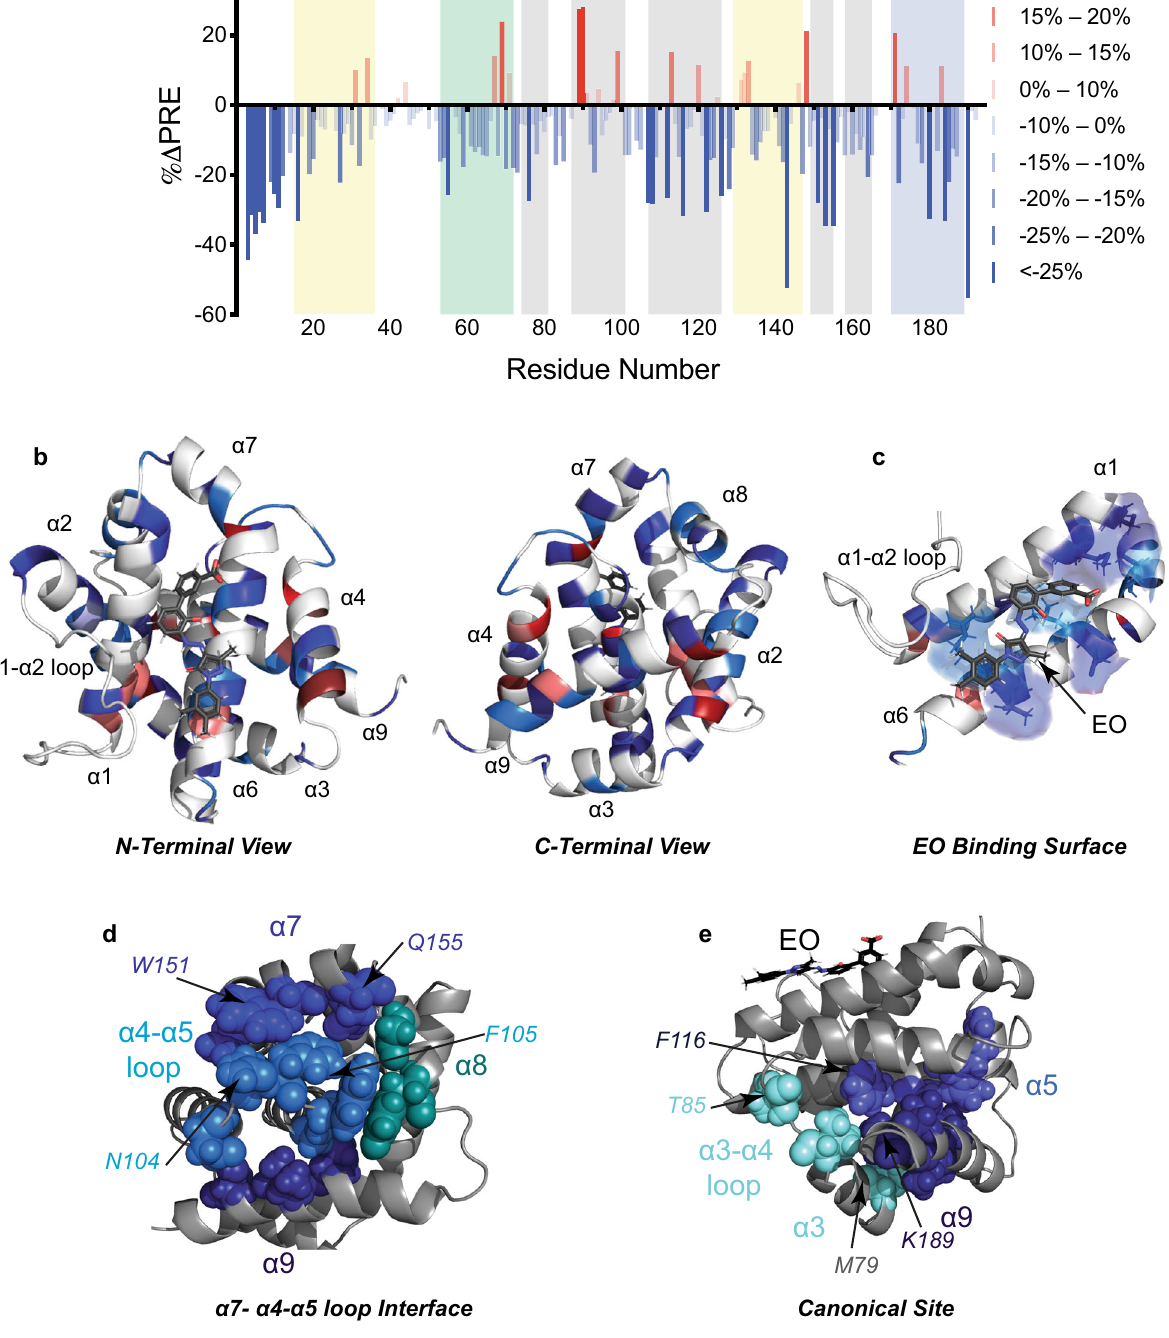
Fig. 5 NMR-based evidence of Eltrombopag-mediated BAX inhibition. a EO-induced differences in peak intensity ratio (PRE) of peaks in the presence and absence of the soluble paramagnetic probe hydroxyl-TEMPO. Percentage change in PRE is plotted with respect to BAX residue number. Residues that exhibit increased or decreased PRE are labeled in shades of red and blue, respectively, the color gradient corresponding to the fi gure key. Residues associated with the N-terminal trigger site, BH3 domain, canonical site, and transmembrane domain are highlighted in yellow, green, gray, and blue, respectively. b Ribbon representation of BAX-EO complex with mapping of residues undergoing signi fi cant differences in PRE as shown in ( a ). c Ribbon representation of EO-binding site with residues undergoing signi fi cant change in PRE colored corresponding to ( a ) and represented as a transparent surface with stick representation of residues. d , e Cluster of residues about the α 7/ α 4 – α 5 loop interface ( d ) and canonical site ( e ) which exhibited reduced PRE in the presence of EO. Colors correspond to the location of the residue within the tertiary structure of BAX as indicated by the fi gure labels. Source data for this fi gure is